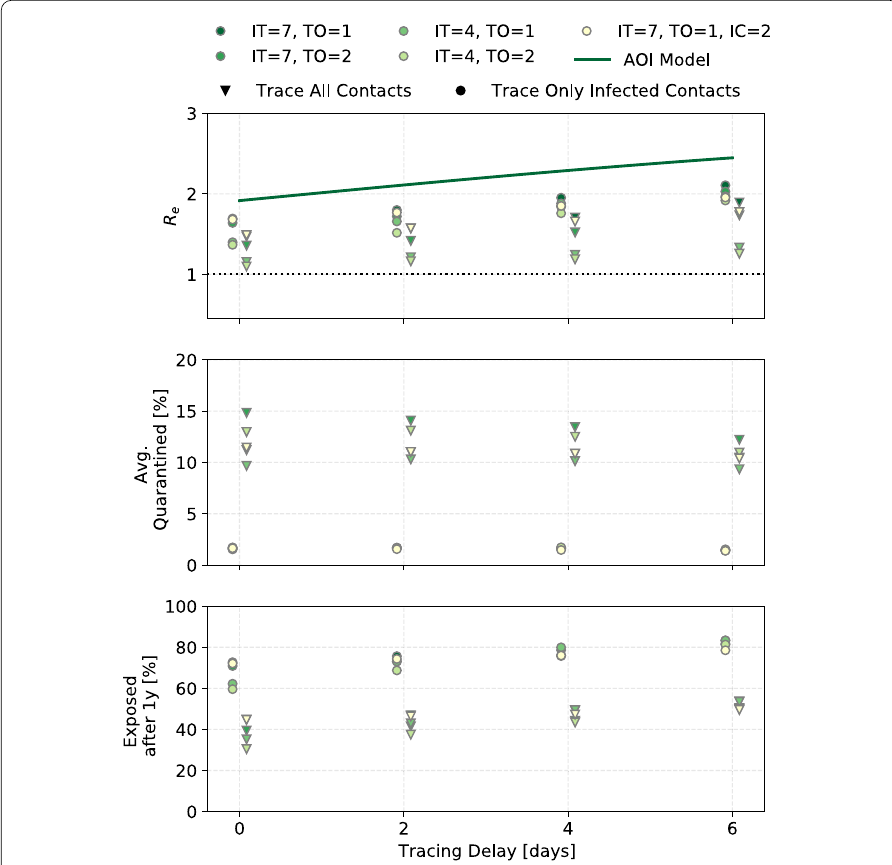
Figure 12 The effect of incubation time (IT) and tracing order (TO) for different tracing delays. IT = 7 refers to the curve with mean incubation period of 7 days, and IT = 4 to the one with mean incubation period of 3.6 days. The yellow point shows results for the alternate transmission probability curve (IC) as shown in Tab. 1 (grey values). Predictions from the “age-of-infection” (AOI) model, where only infected contacts are traced, are shown as the dark green line for parameters IT = 7, TO = 1 - the result shown is not exact (see Suppl. Materials). This is for p app = 0.75, η DCT = 1, and α · f m =